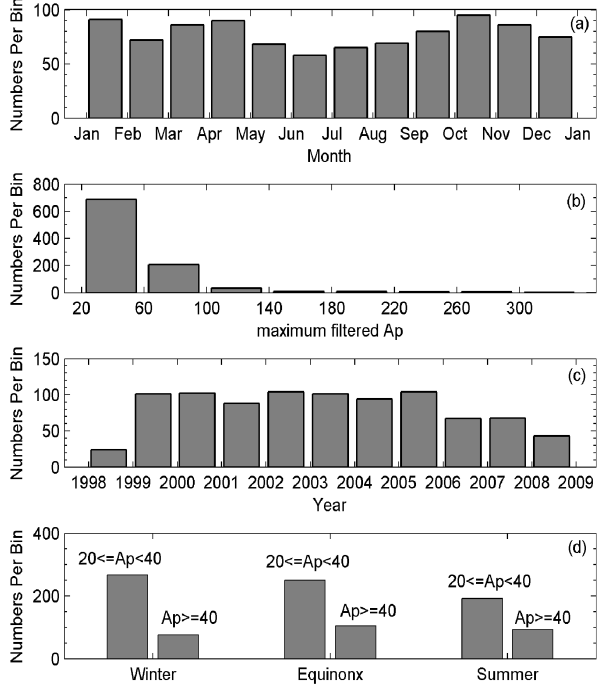
Fig. 2. (a) Total event numbers every month. (b) Distribution of the maximum filtered Ap. (c) Yearly event numbers of the geomagnetic Fig.2. (a) Total event numbers every month disturbances. (d) Seasonal distribution of the filtered Ap in bins: (b) Distribution of the maximum filtered Ap 20 ≤ filtered Ap < 40 and filtered Ap ≥